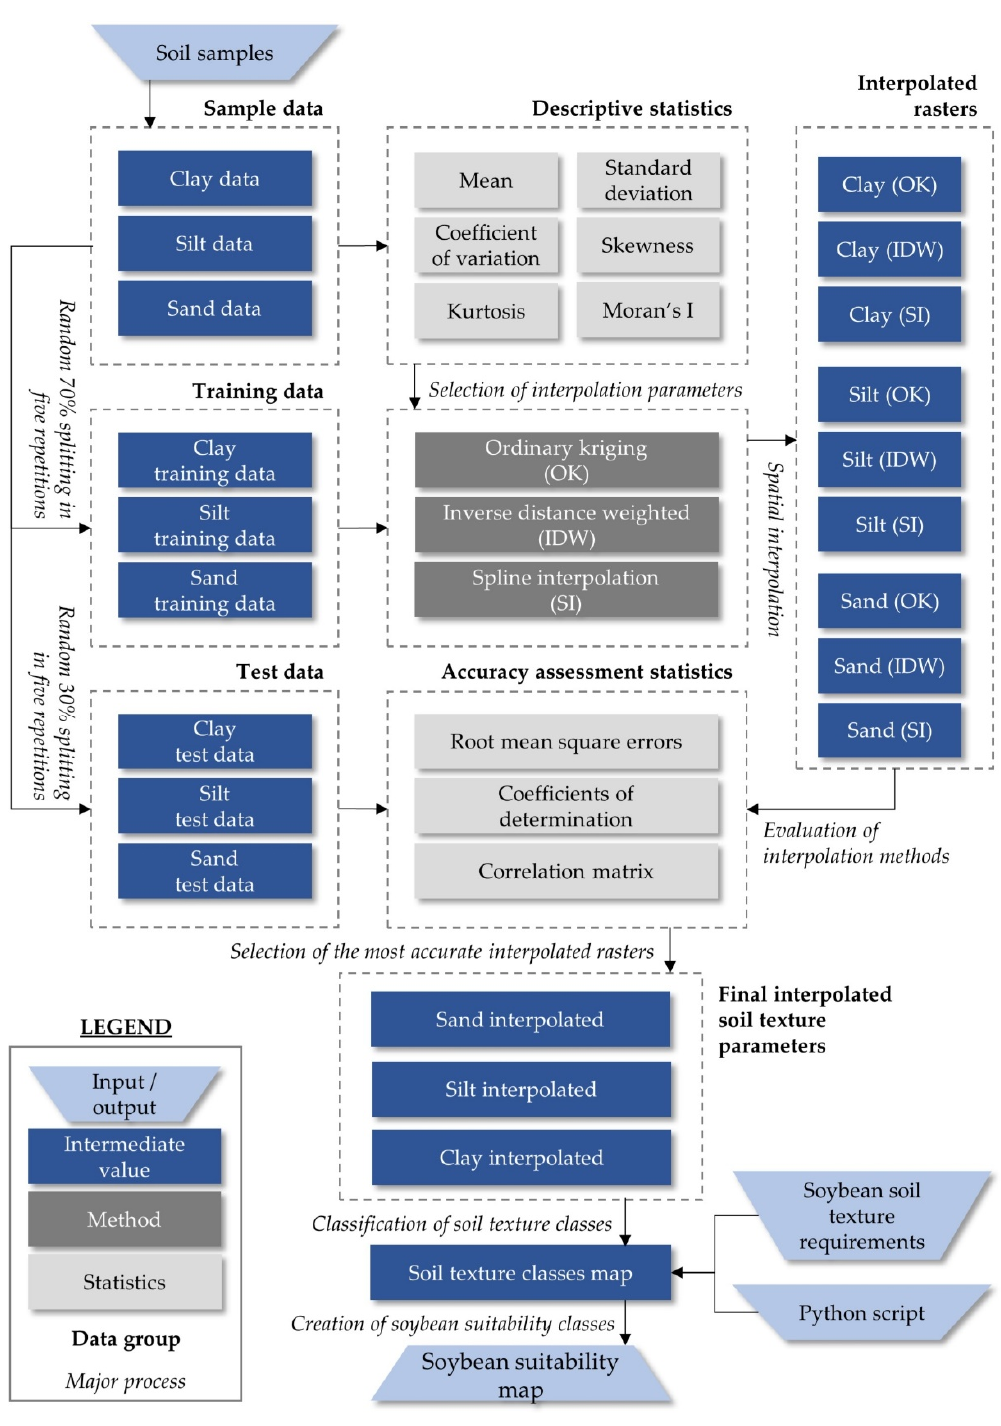
Figure 2. Research workflow for the delineation of soil texture suitability zones for soybean cultivation.